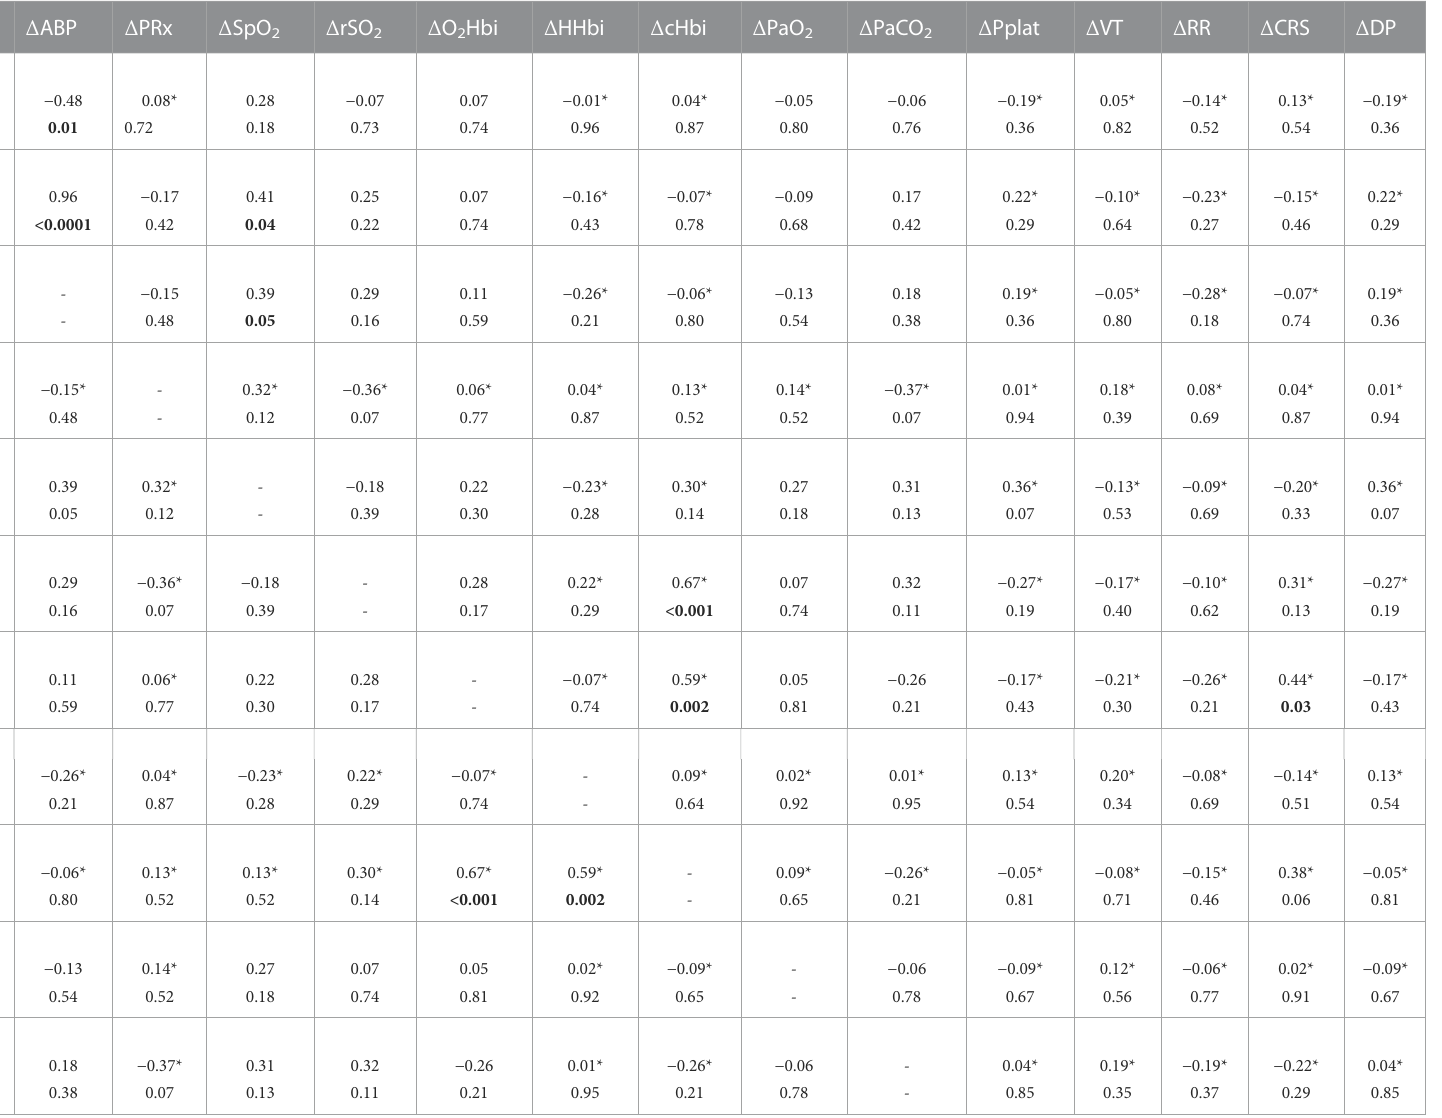
TABLE 3 Correlation matrix between changes ( Δ ) in systemic, ventilatory and neuromonitoring parameters.